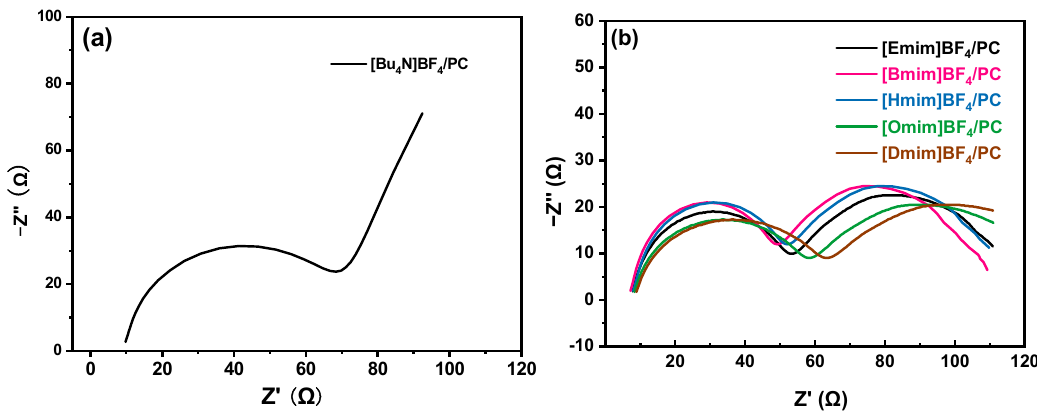
Figure 4. Nyquist plots of electrochemical impedance spectroscopy (EIS) in 0.1 M CO 2 -saturated [Bu 4 N]BF 4 /PC ( a ) and different ILs/PC ( b ) electrolyte solutions.